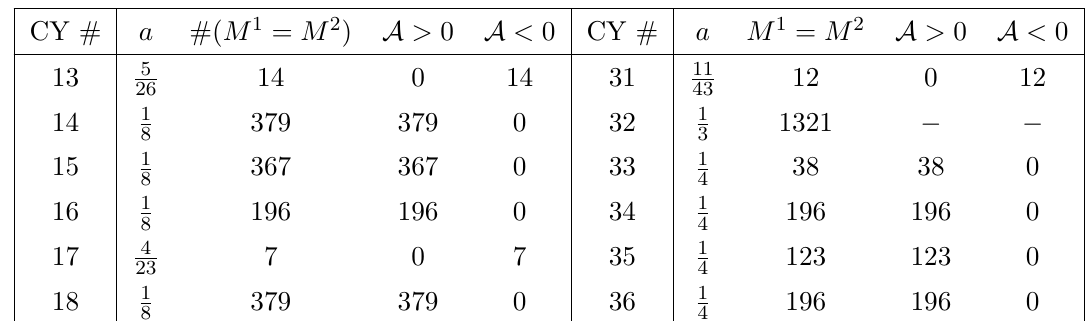
Table 3. Number of PFFV configurations with M 1 = M 2 = a H 1 /F 2 along with the sign( A ) where A is defined in eq. (3.2). There are 5 cases for which the parameter A turns out to be of the form 0 which we will explore 0